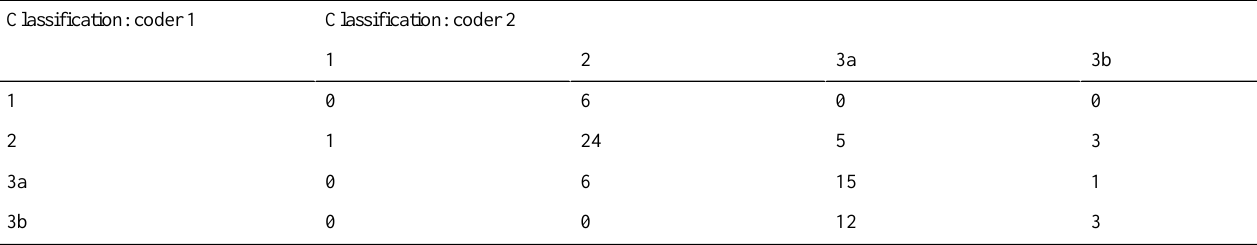
Table 3. Number of apps coded into each functional tier classification, for both coders.